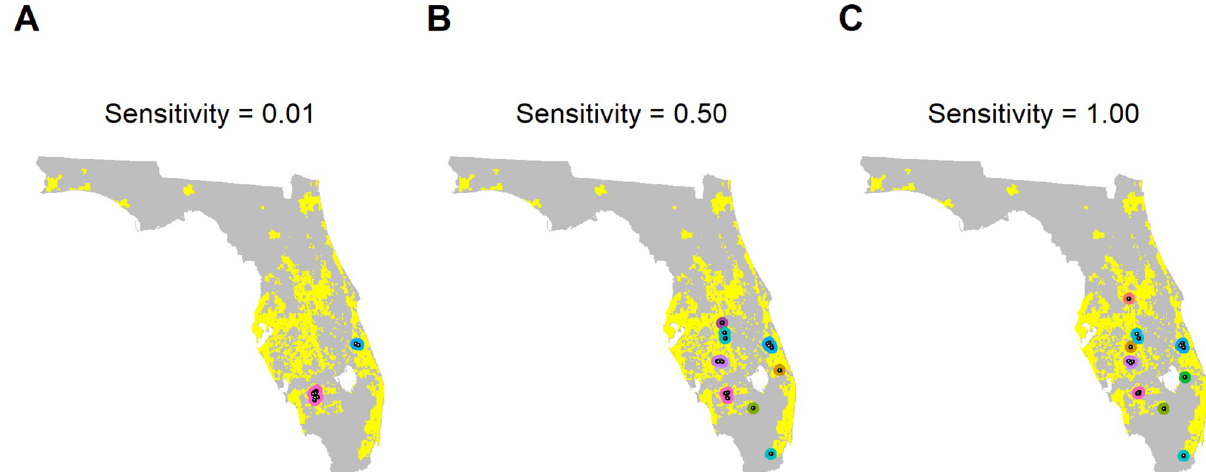
Fig 3. Impact of test sensitivity on optimal sampling pattern. These plots show an example of the optimal distribution of sampling sites and clusters (points within 20 km of each other; shown in distinct colours) when the probability of correctly identifying any sampled infected tree (the diagnostic sensitivity) is low (0.01; plot A), medium (0.50; plot B), and high (1.00; plot C). The data used to create these plots can be found at https://doi.org/10. 17866/rd.salford.12759929.v1 (file